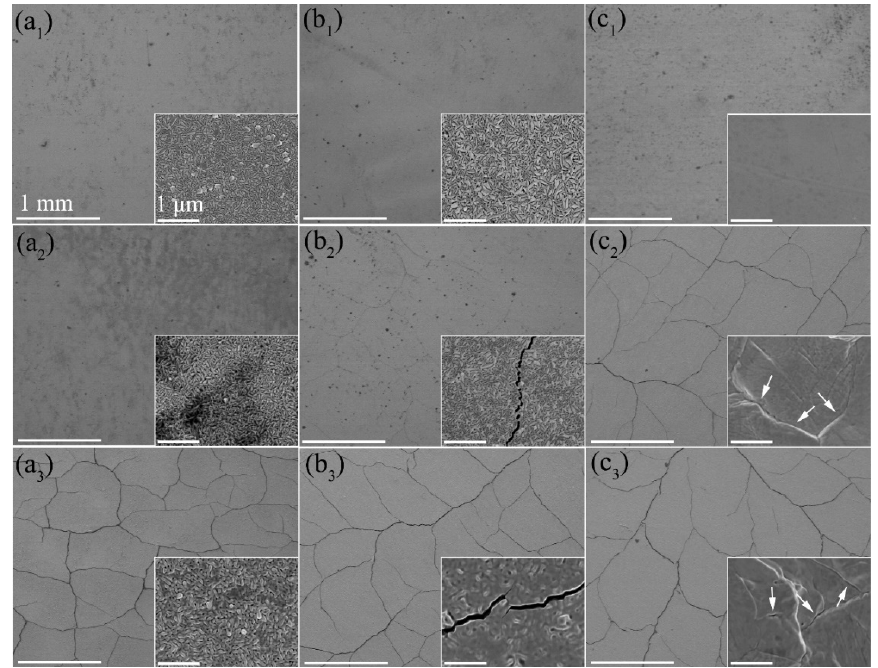
Figure 3. The SEM images of nanochannel W films W-150W-1 ( a 1 ,a 2, a 3 ), W-50W-1 ( b 1 ,b 2 ,b 3 ), and bulk W ( c 1 ,c 2 ,c 3 ) exposed to ELM-like transient thermal shock loads with 100 pulses at RT. The absorbed power density was 0.16 GW/m 2 ( a 1 , b 1 , c 1 ), 0.28 GW/m 2 ( a 2 , b 2 , c 2 ), and 0.43 GW/m 2 ( a 3 , b 3 , c 3 ), respectively. Insets show the corresponding magnified images. The white arrows in c 2 and c 3 indicate the microstructure and microcracks at grain boundaries. The corresponding scale is